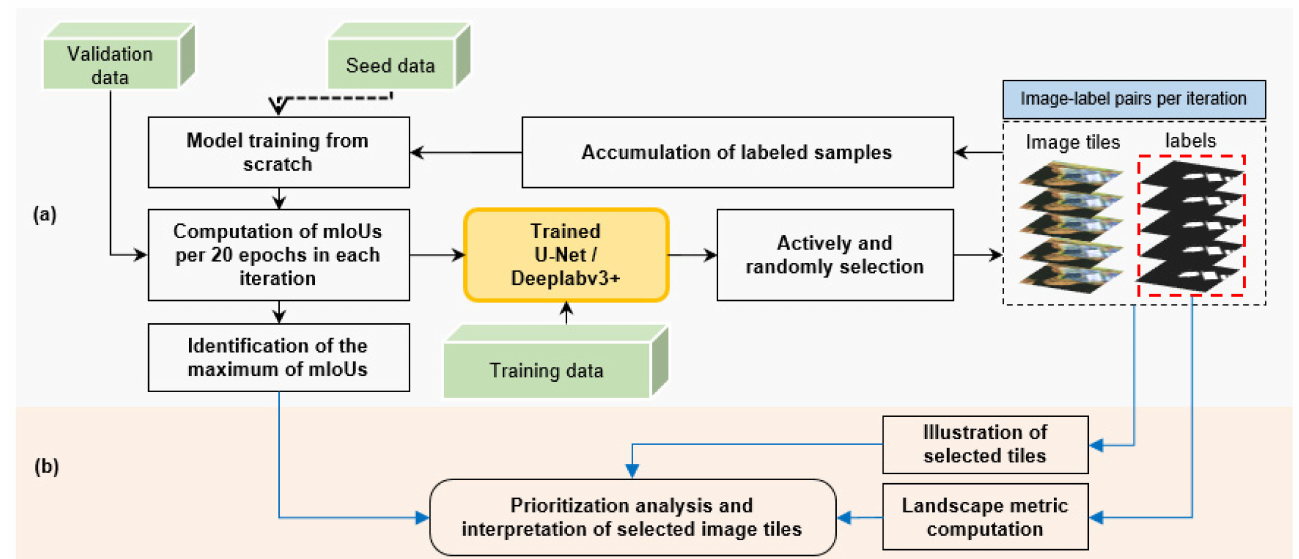
Figure 1. The framework for suggestive data annotation in CNN-based building footprint mapping. Part ( a ) represents the process of deep active learning for building footprint mapping. Part ( b ) rep- resents the steps of interpreting selected image tiles in each iteration by landscape characterization and visual comparison. The dotted arrow denotes the model training in the first iteration based on the seed set. The black arrows denote the steps in the deep active learning process. The blue arrows denote the steps in the interpretation of selected building/non-building